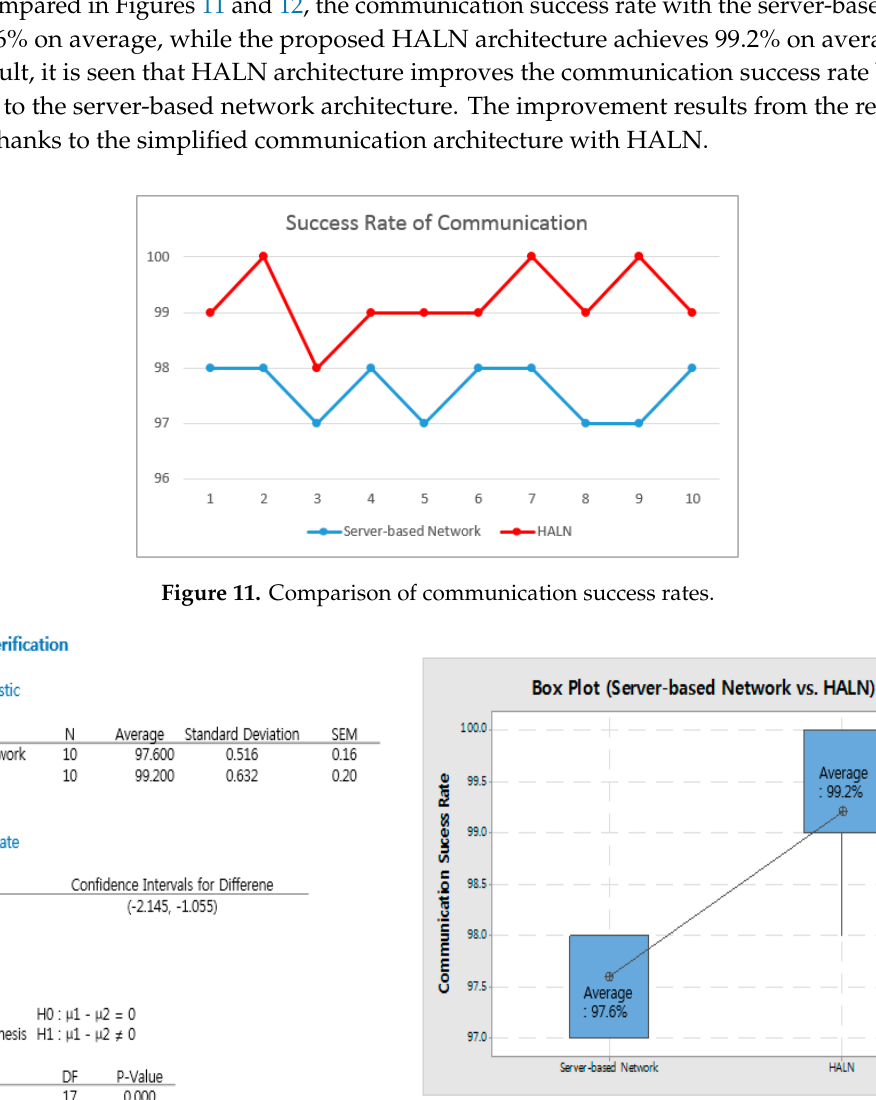
Figure 10. Screenshot of smartphone application the displaying remaining cooking time of the smart oven.